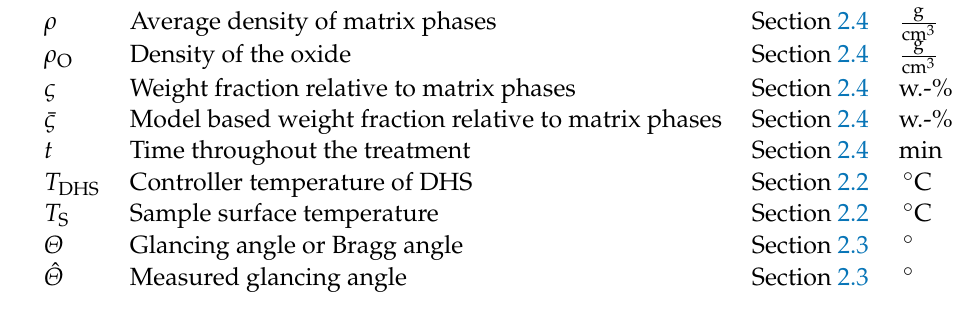
Figure A2. Estimated FWHM of the Lorentzian component function fitted to the ( 002 ) - γ -peak over the time spent in the HT measured with in-situ